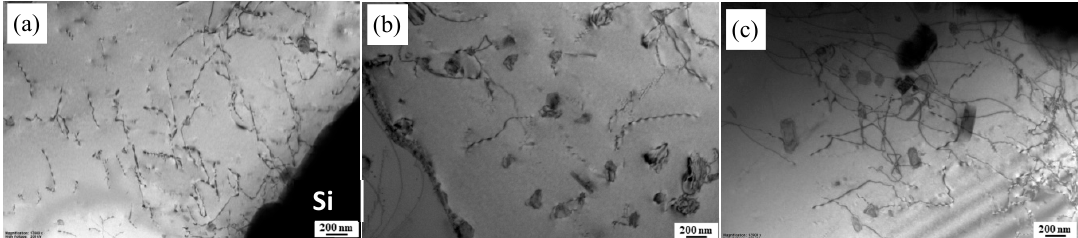
Figure 9. TEM images at the NZs of FSW joints under different initial heat treatment states: ( a ) T1; ( b ) T4; ( c ) T6.